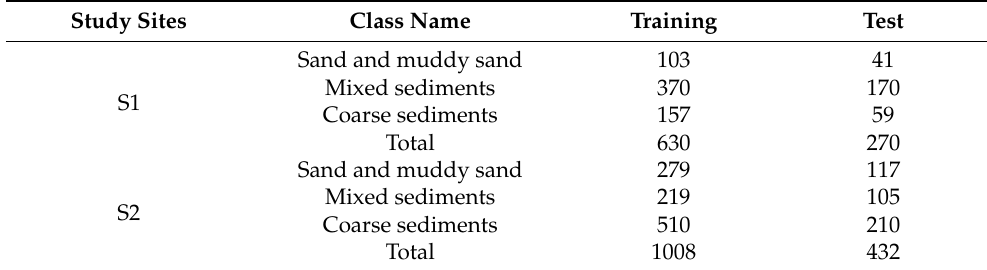
Table 1. Number of training and test samples.